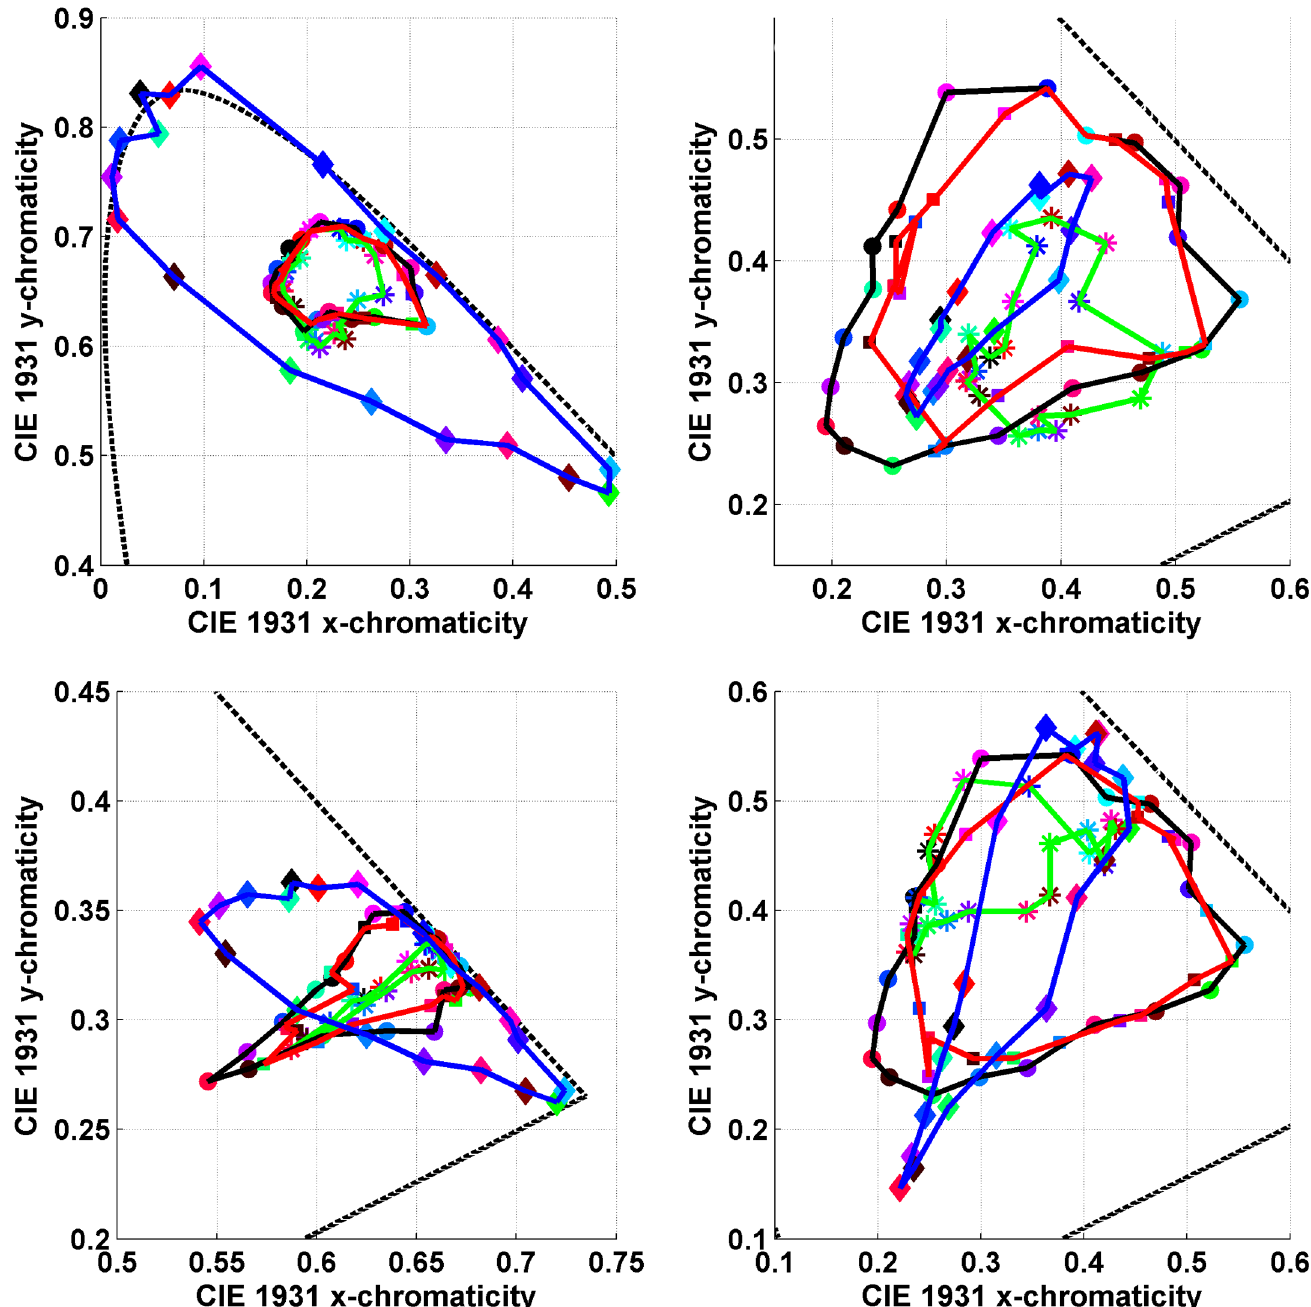
Fig 8. Continuation of the comparisons in Fig 7. The axes are those of the CIE 1931 xy-chromaticity diagram. (Upper Left) Neutral/Green asymmetric colour matching condition where again some of the predictions using the von Kries transformation (blue curve) fall outside the spectrum locus. (Upper Right) Green/Neutral asymmetric colour matching condition. (Lower Left) Neutral/Red asymmetric colour matching condition. (Lower Right) Red/Neutral asymmetric colour matching condition.